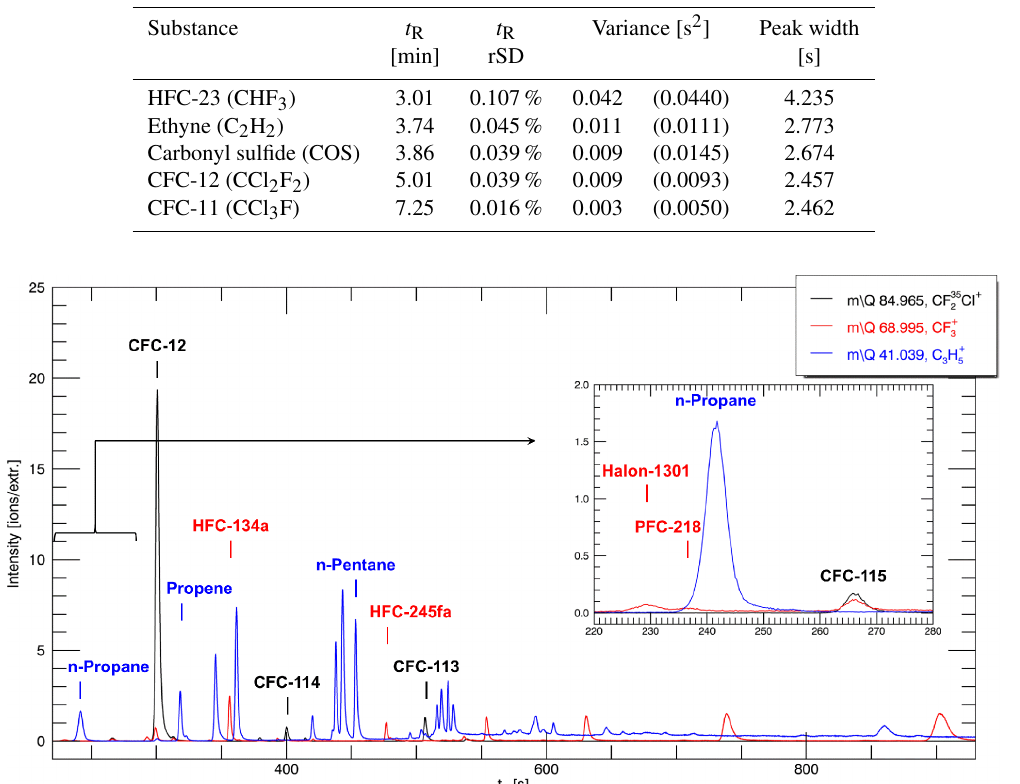
Figure 4. Chromatogram from a 1L ambient air sample obtained with the GC–MS set-up described in Obersteiner et al. (2016). X axis: retention time t R in seconds. Y axis: signal intensity expressed as ions per extraction which are derived from a 22.7kHz TOFMS extraction rate, averaged to yield a mass spectra rate of 4Hz. X and y axis descriptions are also valid for the magnified section. Black graph: mass- to-charge ratio ( m/Q ) = 84.965 signal from a typical CFC fragment ion CF 35 Cl + . Red graph: m/Q = 68.995 signal from a typical PFC 2 . Blue graph: m/Q = ,41.039 signal from a typical hydrocarbon fragment ion C 3 H + . The magnified section or HFC fragment ion CF + 3 5 shows the chromatographic peak of propane and three other compounds to demonstrate injection quality of substances least refocused by